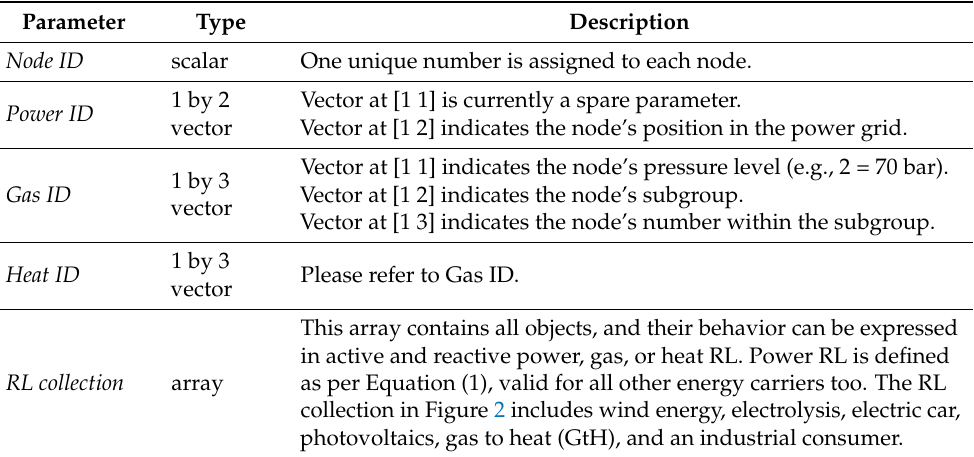
Table 1. Overview node class